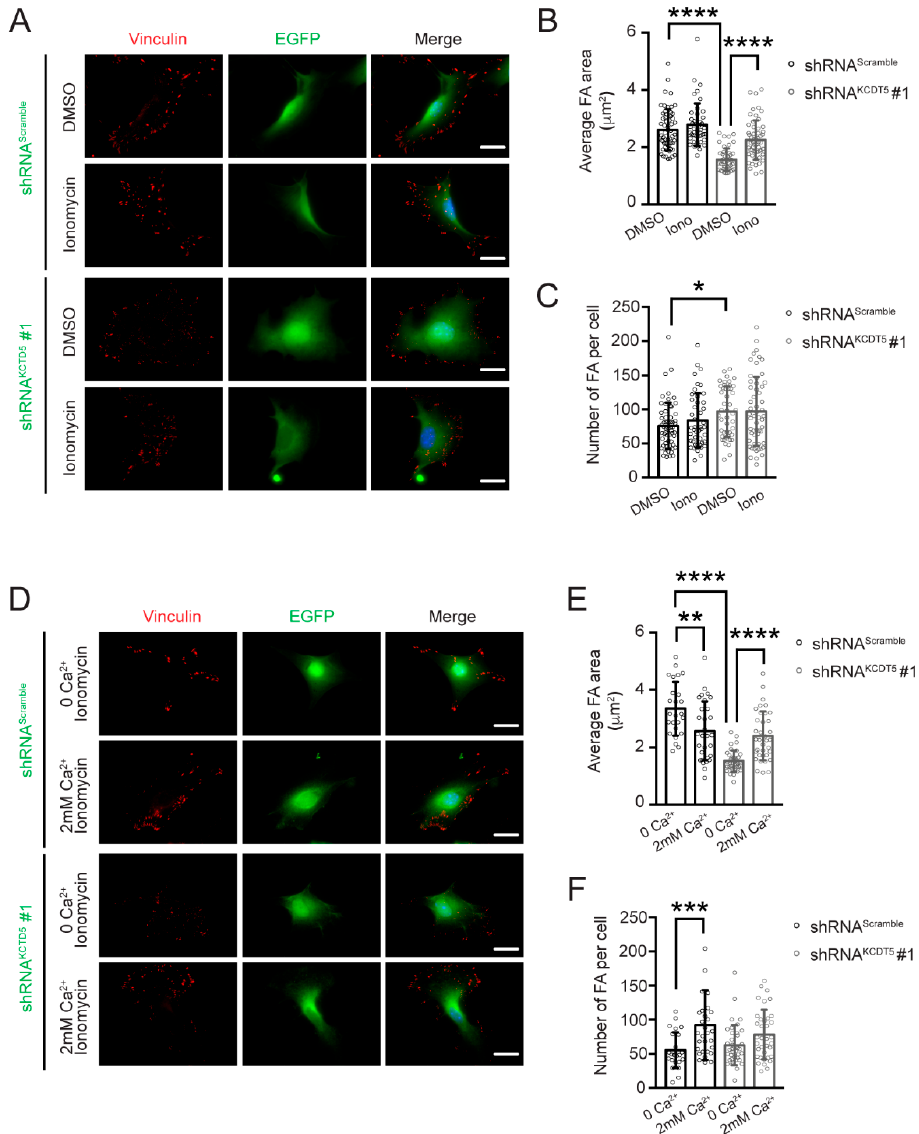
Figure 6. Ca 2 + mediates the KCTD5-promoted focal adhesion size regulation. ( A ) Representative images of B16-F10 transfected with shRNA Scramble or shRNA KCTD5 #1 encoding plasmids. Cells were serum-starved for 4 h and then were treated with 1 µ M ionomycin in a 2 mM CaCl 2 Krebs medium for 20 min. DMSO was used as a vehicle control. Focal adhesions were labeled with mouse mAb anti-vinculin (red). Focal adhesions of EGFP positive cells were analyzed. Scale bar = 25 µ m. ( B ) Graph representing the Average of focal adhesion area per cell ( µ m 2 ) for each condition (mean ± SD; n = 4; Two-way ANOVA followed by Sidak’s multiple comparisons test, **** p < 0.0001). ( C ) Graph representing the Number of focal adhesions per cell for each condition (mean ± SD; n = 5; Two-way ANOVA followed by Sidak’s multiple comparisons test, * p < 0.05). ( D ) Representative images of B16-F10 transfected with shRNA Scramble or shRNA KCTD5 #1 encoding plasmids. Cells were serum-starved for 4 h and then were treated with 1 µM ionomycin in a Ca 2+ -free (0 Ca 2+ ) or a Ca 2+ -containing (2 mM Ca 2+ ) Krebs medium for 20 min. Focal adhesions were labeled with mouse mAb anti-vinculin (red). Focal adhesions of EGFP positive cells were analyzed. Scale bar = 25 µm. ( E ) Graph representing the Average of focal adhesion area per cell (µm 2 ) for each condition (mean ± SD; n = 4; Two-way ANOVA followed by Sidak’s multiple comparisons test, ** p < 0.01, **** p < 0.0001). ( F ) Graph representing the Number of focal adhesions per cell for each condition (mean ± SD; n = 4; Two-way ANOVA followed by Sidak’s multiple comparisons test, *** p <